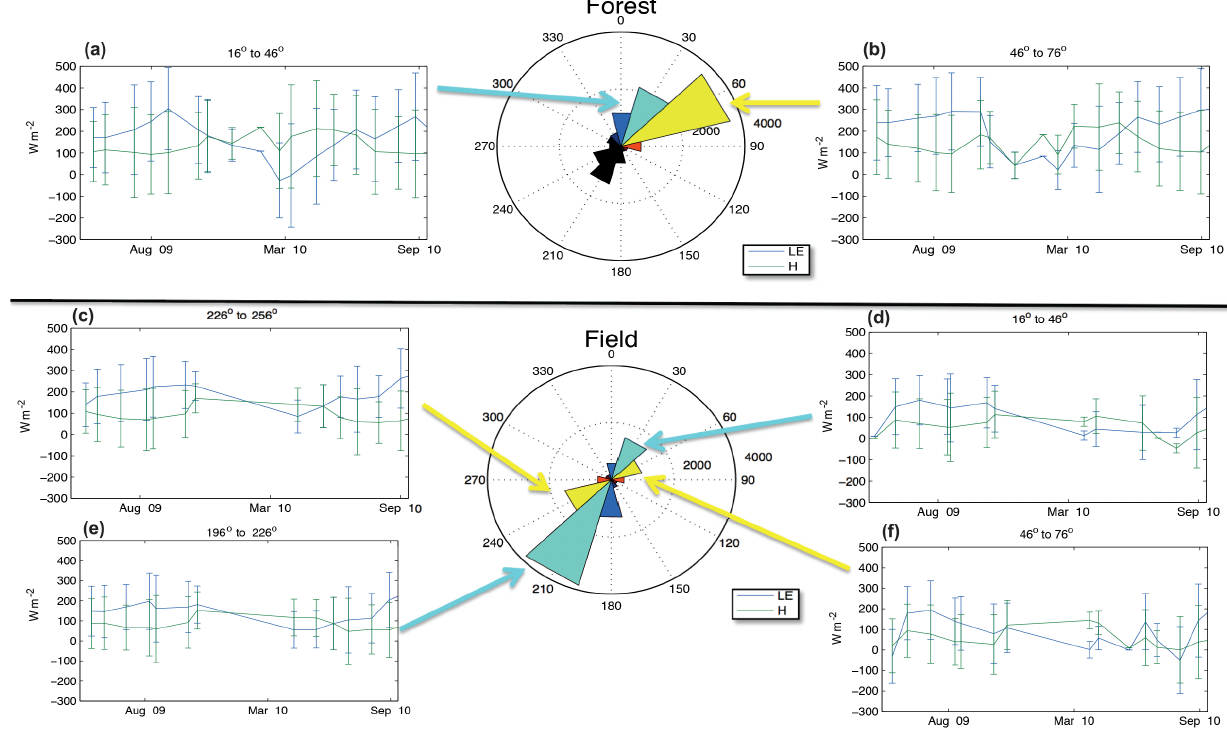
Figure 6. Two dominant wind sectors for each eddy-covariance setup are plotted: over the savanna forest (a, b) and over the agricultural field (c–f) . Mean latent heat flux for each month with standard deviations is shown in blue and sensible heat in green. Note that for some months there were no